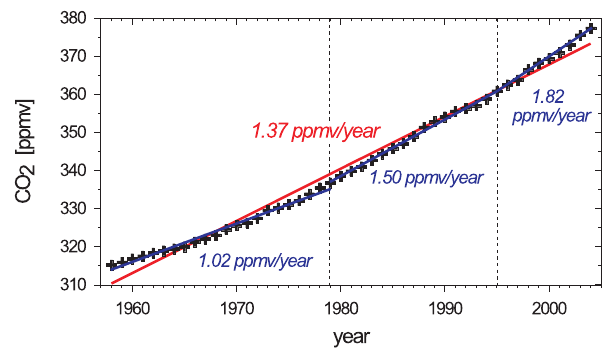
Fig. 14. Long-term variation of CO 2 observed at Hawaii. The red line is the linear trend for the whole interval between 1958 and 2004, the blue lines characterize the trends in different sub-